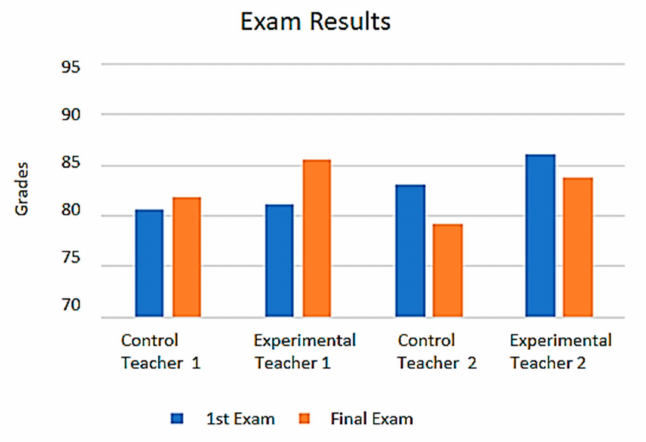
Figure 8. Ratings obtained by the groups.